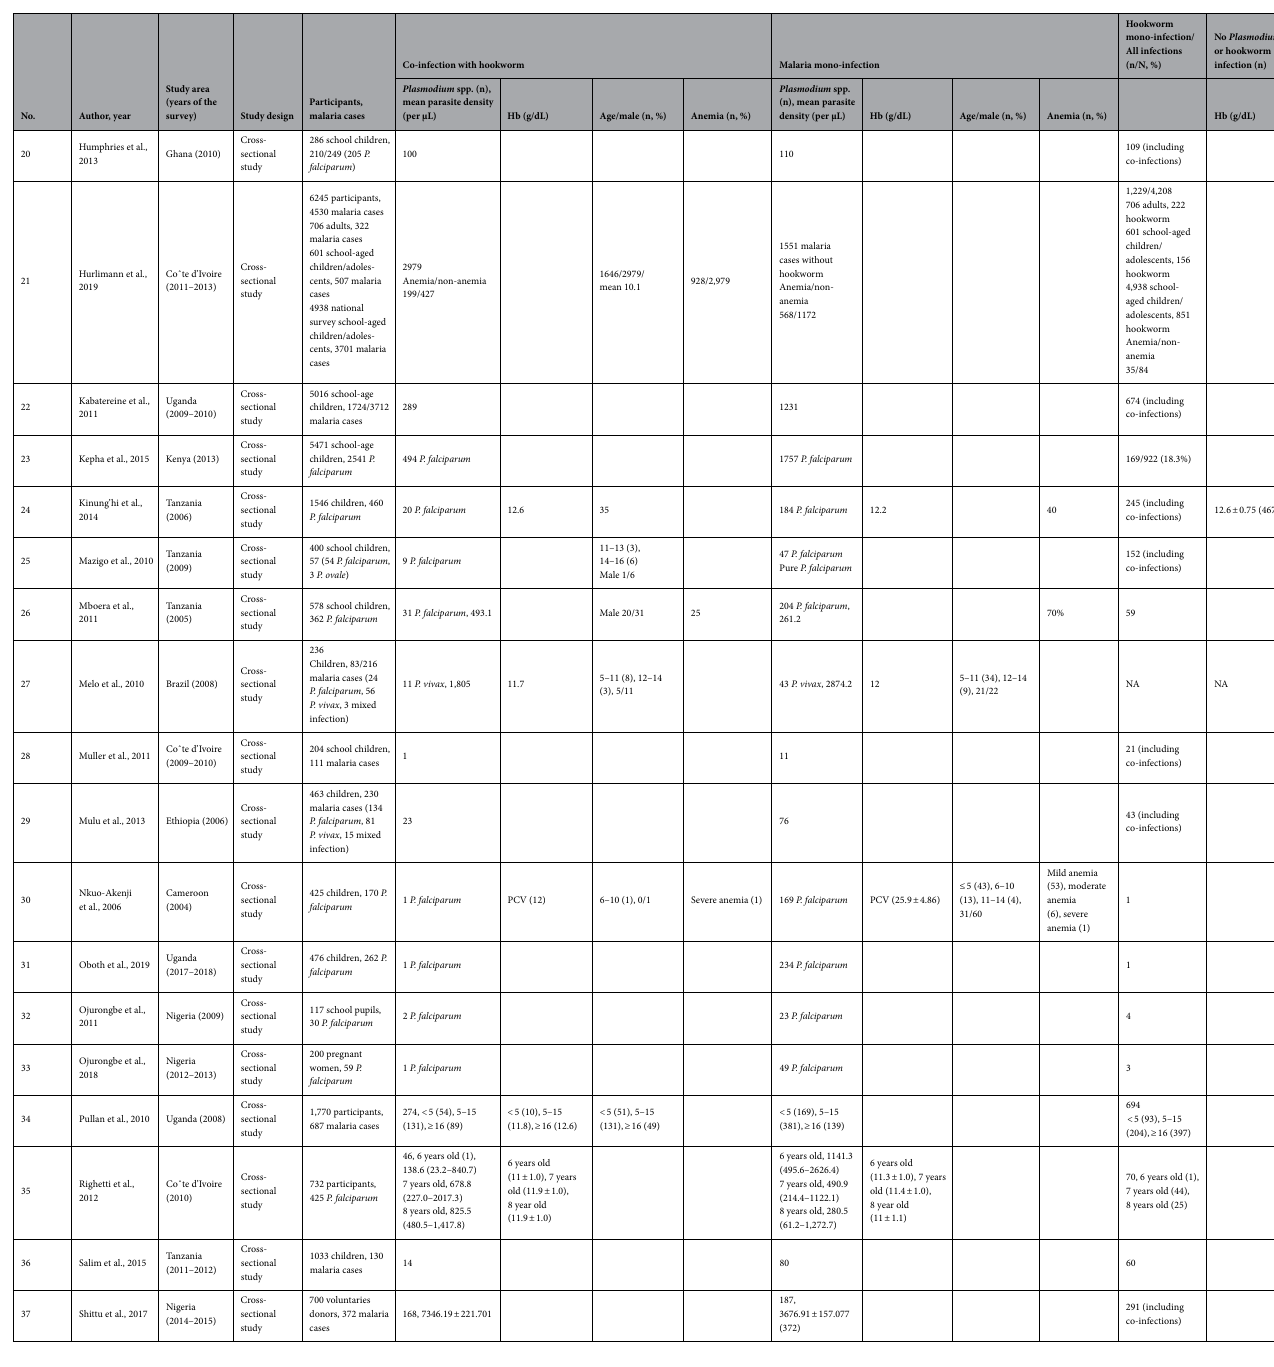
Table 1. Characteristics of the included